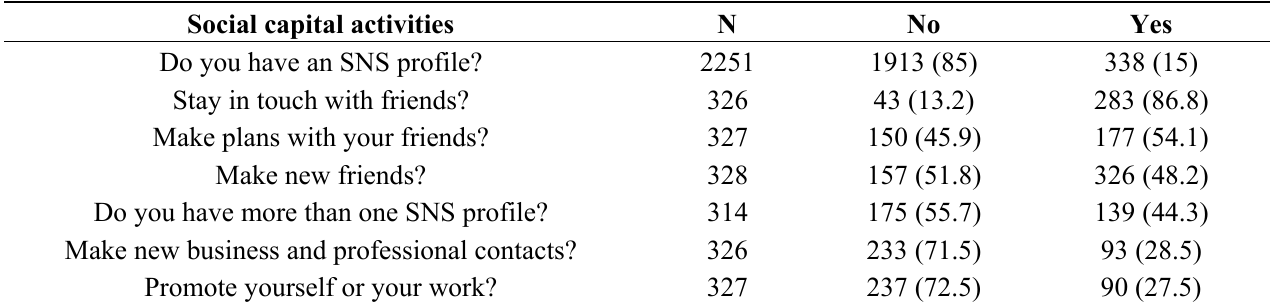
Table 1. Descriptive statistics for dependent variables (% in